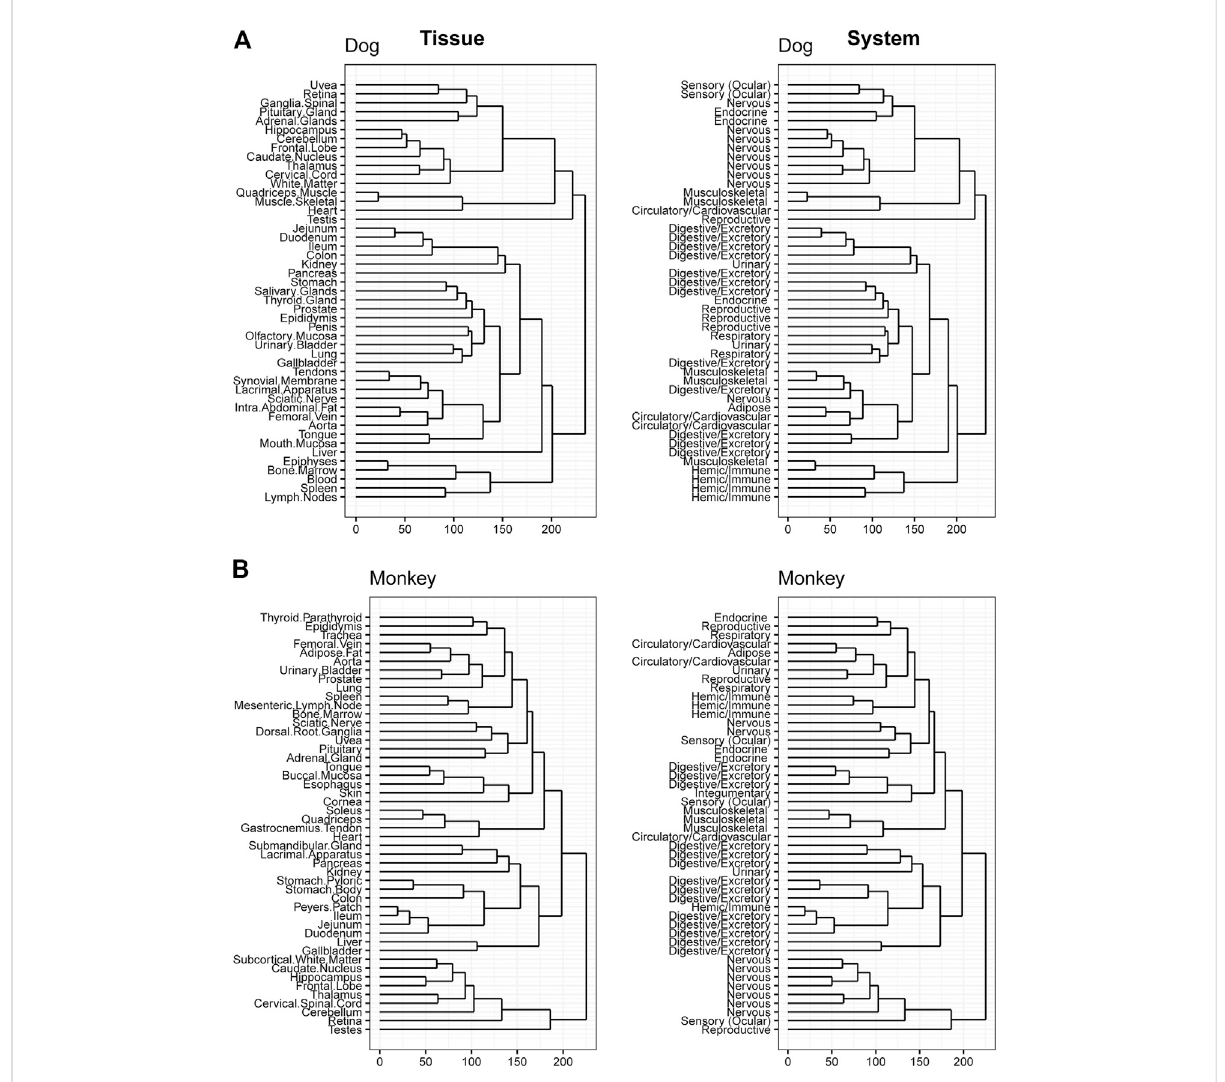
FIGURE 5 Hierarchical Clustering of Tissues in Dog and Monkey. Dendrogram to visualize hierarchical clustering of male tissues (left) in Dog (A) and Monkey (B) . These tissues were also mapped to broader organ/system classi fi cations